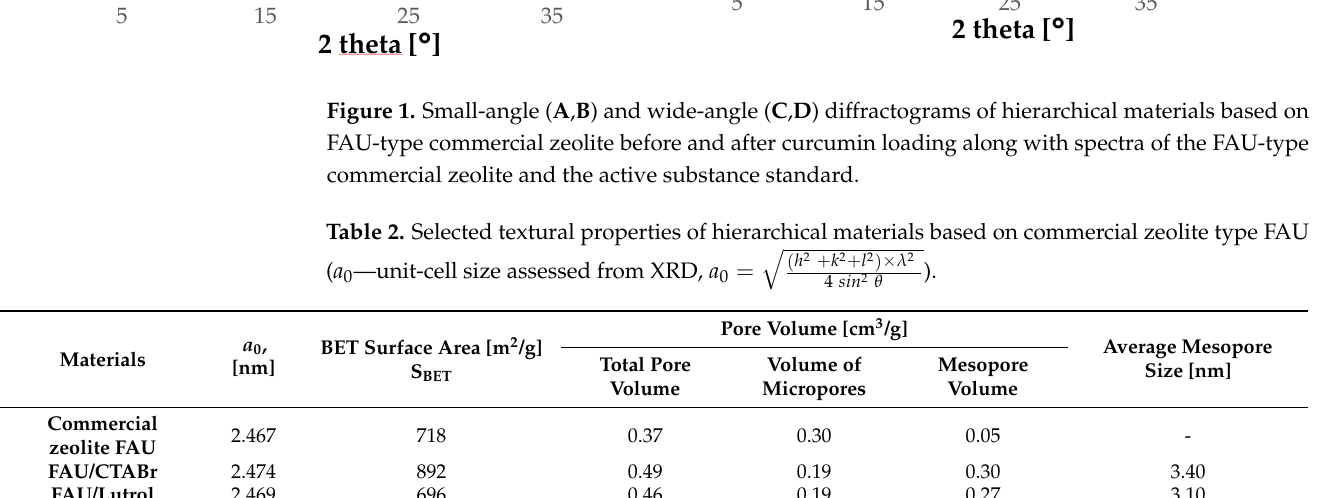
Figure 1. Small-angle ( A , B ) and wide-angle ( C , D ) diffractograms of hierarchical materials based on FAU-type commercial zeolite before and after curcumin loading along with spectra of the FAU-type commercial zeolite and the active substance standard.